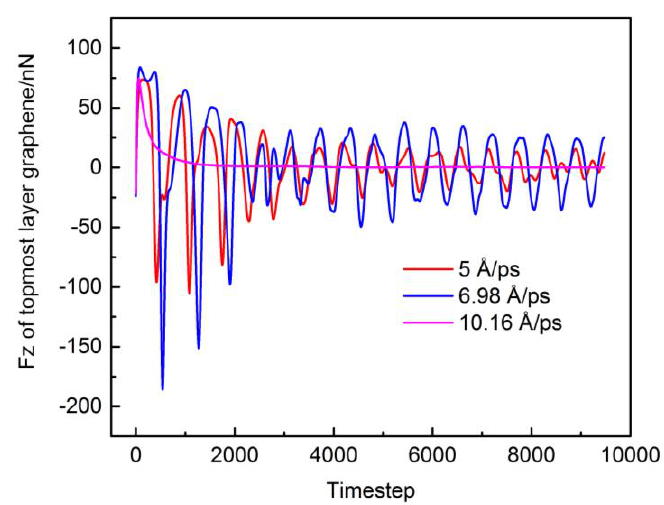
Figure 10. Fz to exfoliate the topmost layer of graphene varying with timestep.